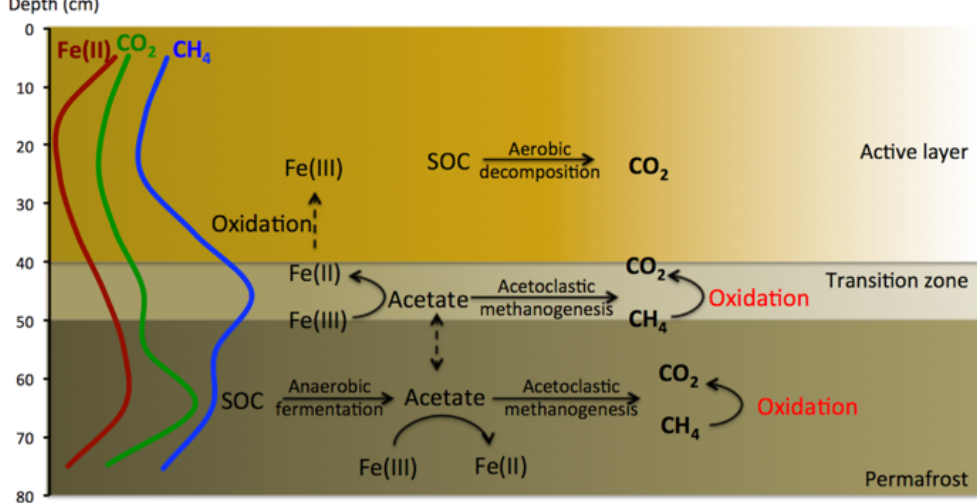
Figure 10. Conceptual model of aerobic and anaerobic soil organic carbon decomposition pathways and the release of CO 2 and CH 4 from a flat-centered polygon (FCP). Lines on the left marked as Fe(II), CO 2 , and CH 4 represent measurements across the soil